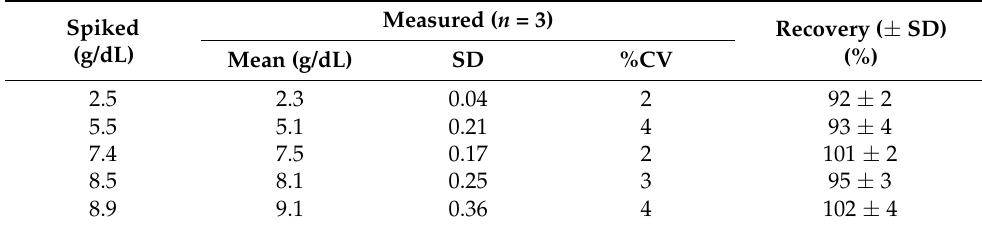
Table 3. Testing of spiked HSA in artificial serum.